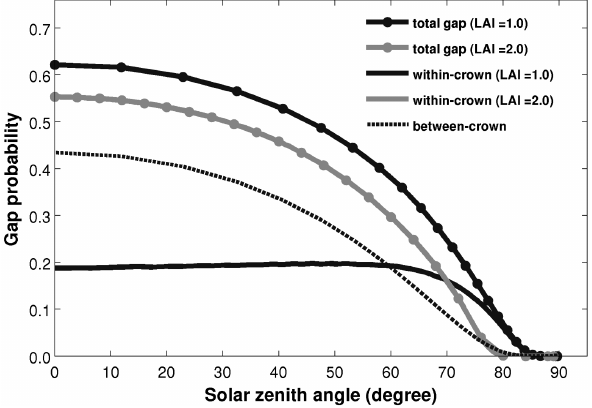
Figure 2. Canopy gap probabilities modeled using GORT with var- ied leaf area index. The total gaps are between-crown gaps plus within-crown gaps. Tree structure parameters for the US-Bar site are used in model simulation.